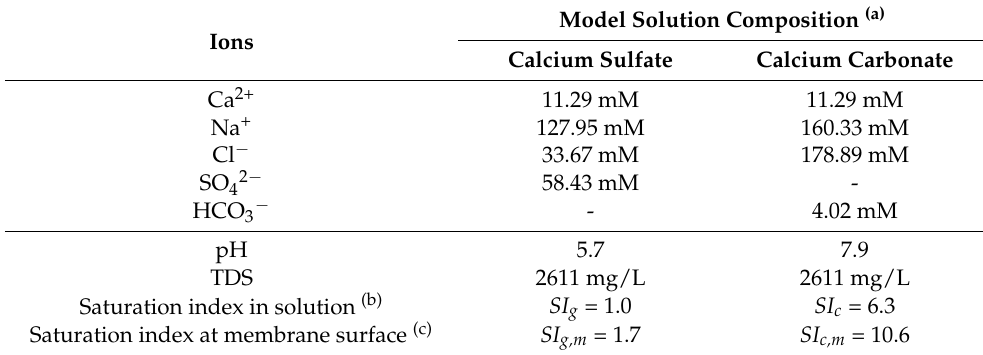
Table 2. Ionic compositions of calcium sulfate and calcium carbonate model solutions. Model Solution Composition Ions